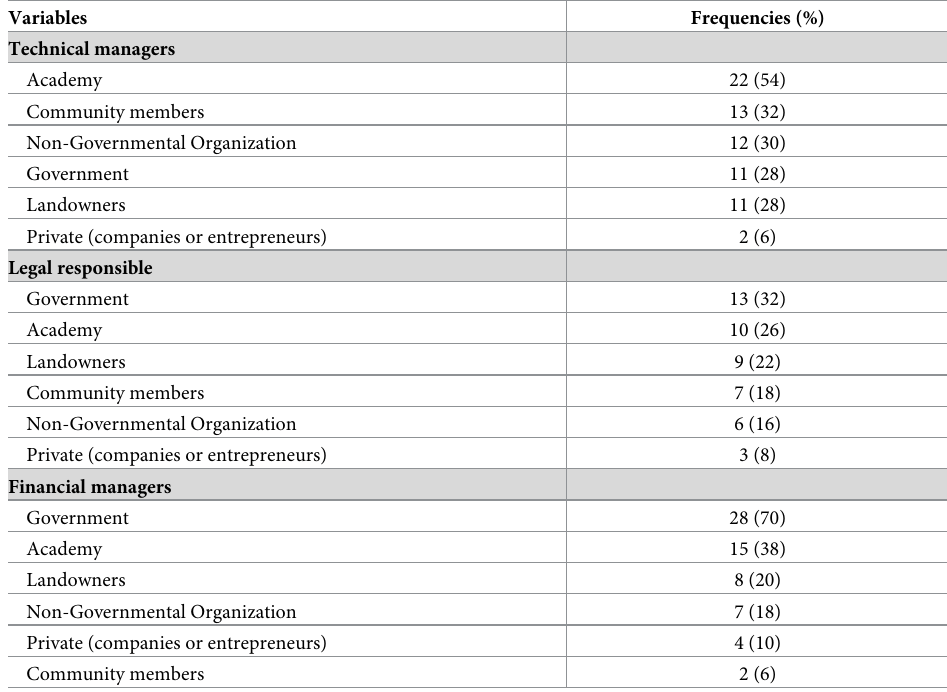
Table 5. Role played by stakeholders of society in the monitoring of restoration projects.